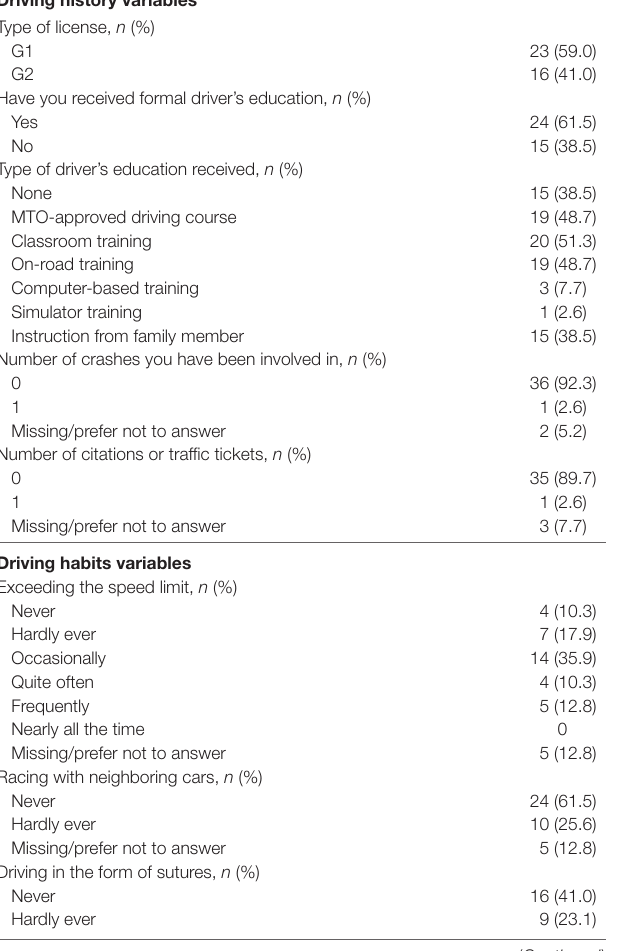
Table 2 | Descriptive statistics for self-reported driving history and habits questionnaire and practice journal variables ( N = 39). Driving history variables